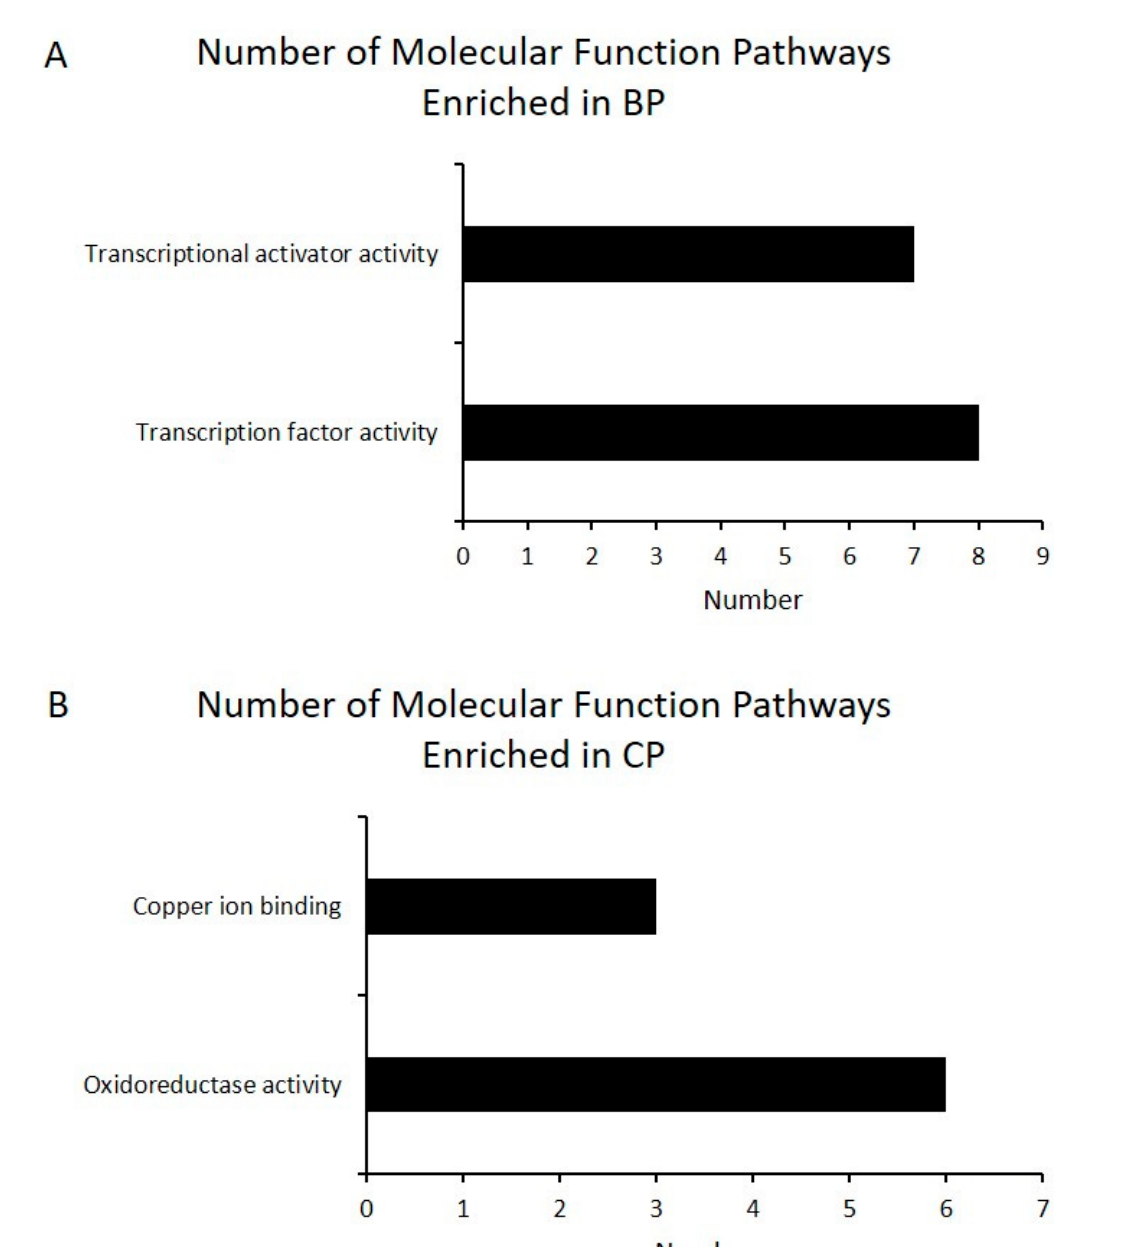
Figure 6. Gene ontology (GO) analysis of differentially expressed genes highly expressed in BP ( A ) and CP ( B ). The identified differentially expressed genes were classified into molecular functions. The number of genes in the GO term is shown above (BP vs. CP; CP: cross-bred commercial pigs, BP: Large Black pigs).